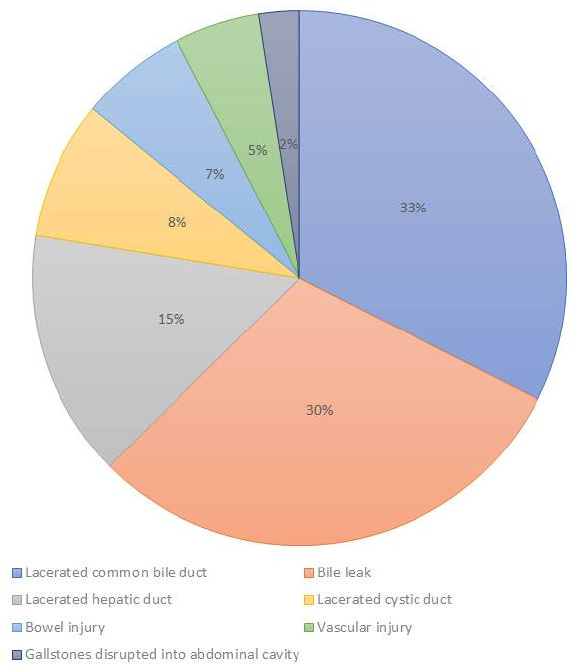
Figure 12. Injuries distribution consequent to laparoscopic cholecystectomy.